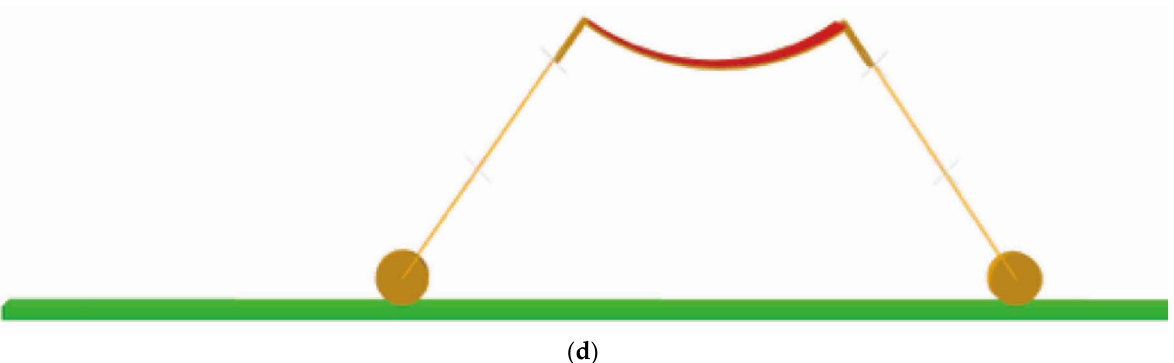
Figure 3. Design and modeling of a DEMES soft machine realized through the combination of a soft DEMES central body and hard legs and wheels. Different friction coefficients are assumed and switched during the process of locomotion. ( a ) Planar view and as-fabricated state of the soft machine. The central body buckles to minimize the total energy of the system. ( b – d ) A series of actuations and motions are taken by the soft machine for forward locomotion.